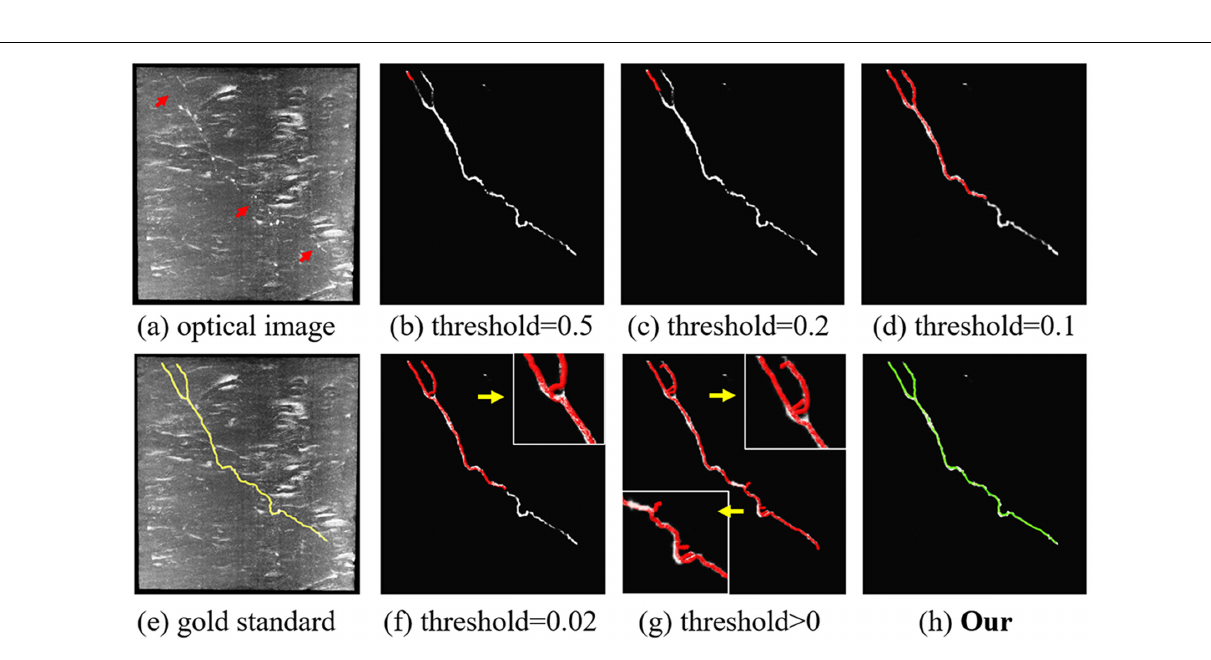
the twisted structures and generated lots of wrong